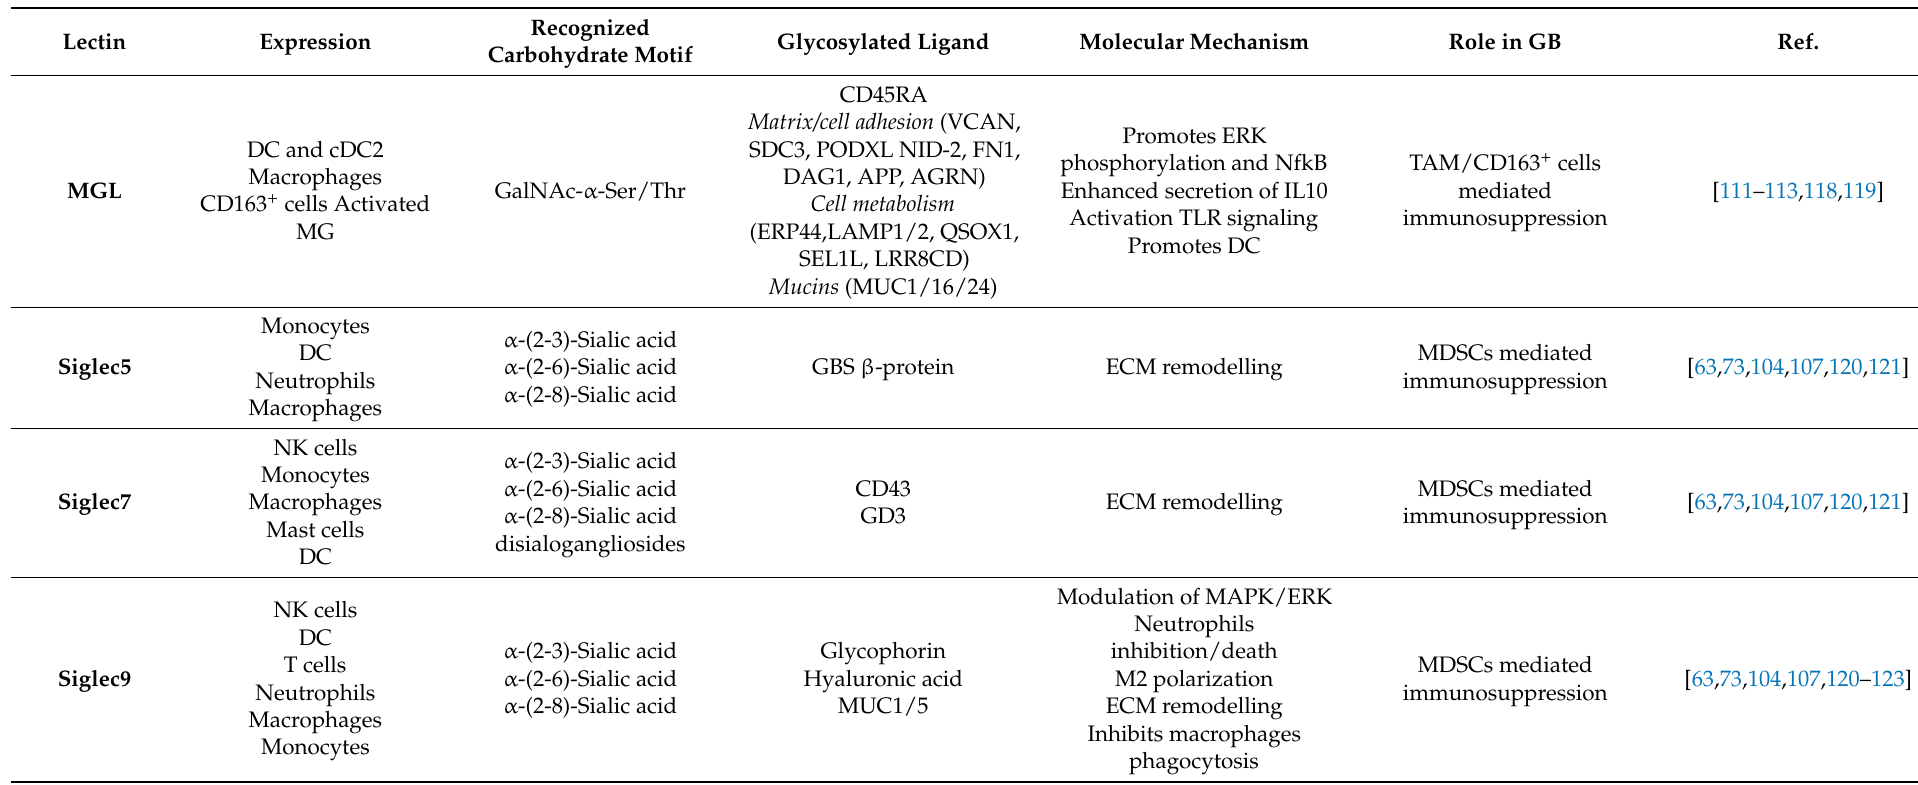
Table 1. Classification, expression, binding preference, glycosylated ligand, known molecular mechanisms and role of C-type lectins and Siglecs in GB. Abbreviations: GalNAc: N-Acetyl-d-galactosamine; MUC1: mucin-1; MUC5: mucin-5; MUC16: mucin-16; MUC24: mucin-24; ERP44: Endoplasmatic Reticulum Resident Protein 44; LAMP1: Lysosome-associated membrane glycoprotein 1; LAMP2: Lysosome-associated membrane glycoprotein 2; QSOX1: Sulphydryl oxidase 1; SEL1L: